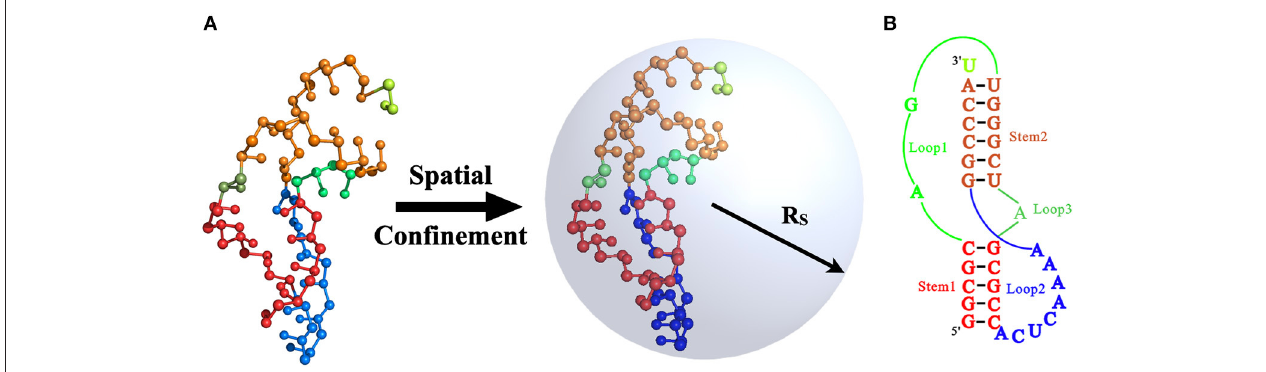
FIGURE 1 | (A) The schematic illustration for the mouse mammary tumor virus (MMTV) pseudoknot under the spatial confinement of radius R S and the 3D structure of the pseudoknot (PDB code: 1rnk; https://www.rcsb.org) in our coarse-grained (CG) representation. (B) The secondary structure for the MMTV pseudoknot consisting two stems and three loops. The corresponding secondary elements in (A,B) are in same colors: Stem 1 (red), Stem 2 (orange), Loop 1 (green), Loop 2 (blue), Loop 3 (dark green), and the 3 ′ dangling nucleotide (light green). The 3D structures in (A) are shown with the PyMol (http://www.pymol.org).